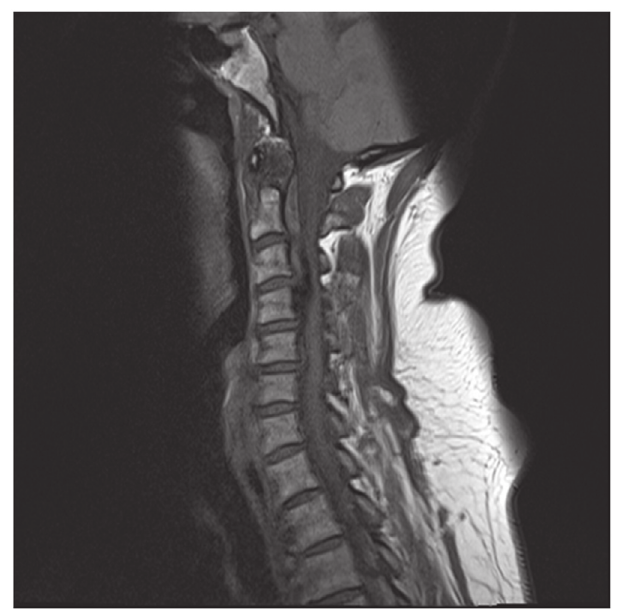
Figure 1. CT Cervical spine demonstrating a large ossified bony bar extending from the posterior surface of the C4 vertebral body up to the level of the upper surface of the C3 vertebral body. There are also multiple areas of calcification involving the intravertebral discs, annulus fibrosis, the ligmentum flavum and the transverse ligament behind the odontoid